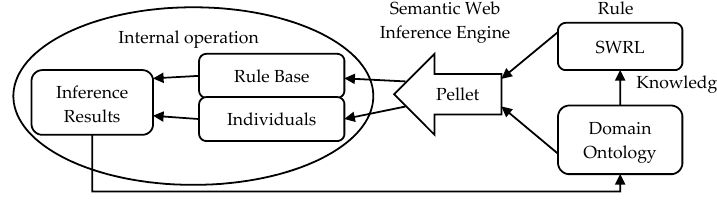
Figure 2. Reasoning system framework.